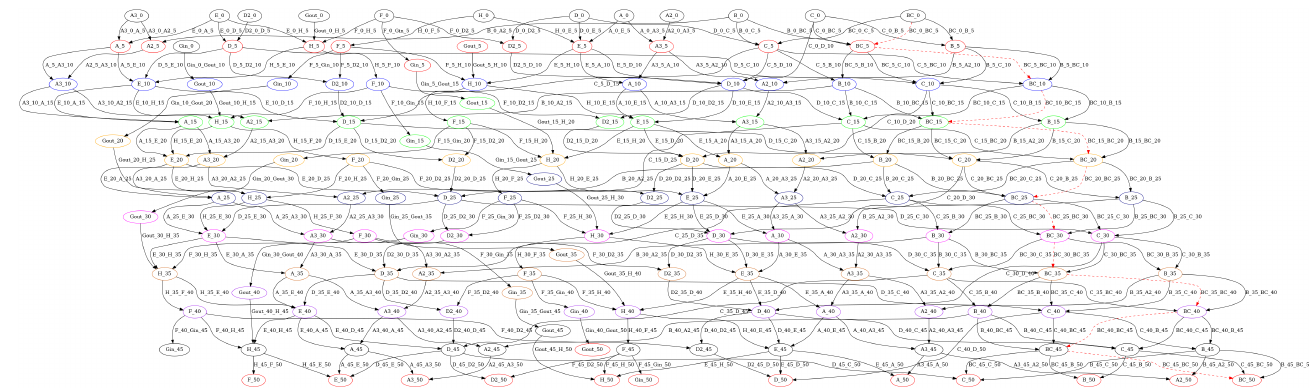
Figure 6. Further revised network.